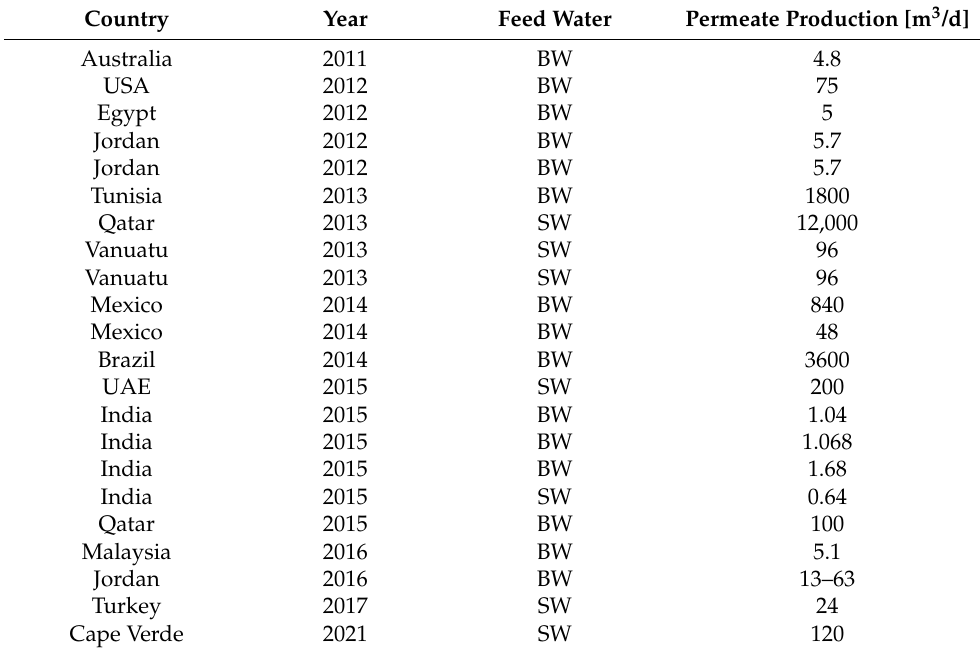
Table 1. Photovoltaic installations used in desalination since 2011 [24,25].